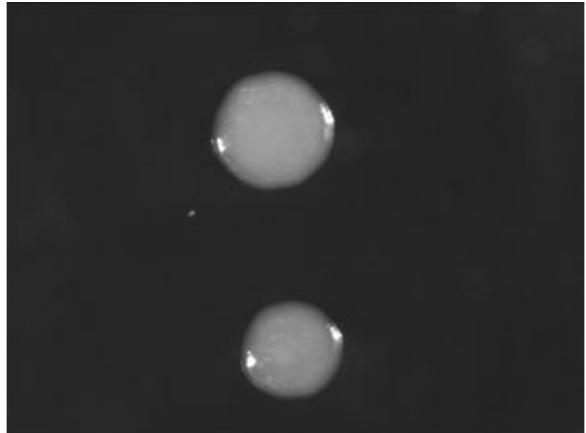
Figure 3. Colonies of Xylella fastidiosa subsp . pauca Salen- to-1, after incubation at 28°C for 20 d on BCYE agar plates.